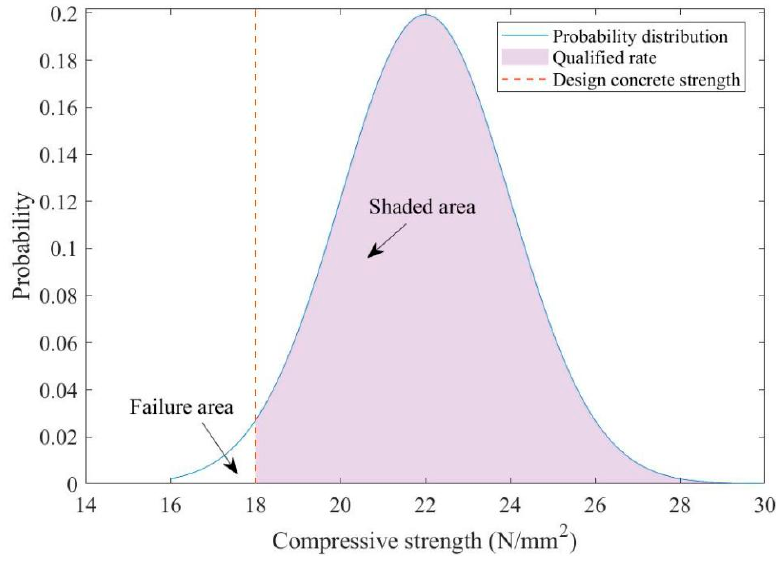
22 =μ = V Figure 17. Normal distribution of µ = 22 and V = 0.09. and 09.0